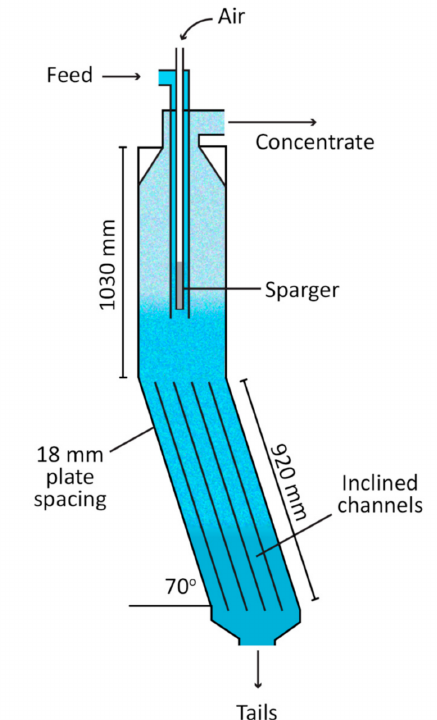
Figure 1. Schematic of the reflux flotation cell (RFC)